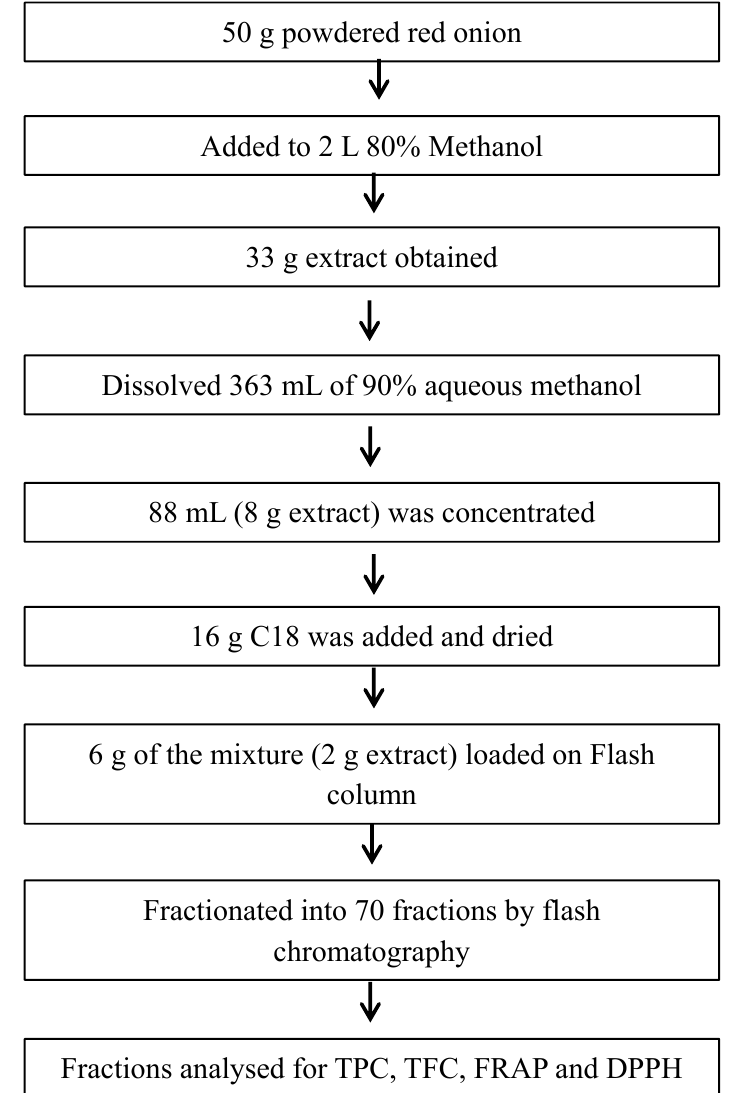
Figure 1. Schematic diagram of the fractionation of the onion extracts by flash chromatography.